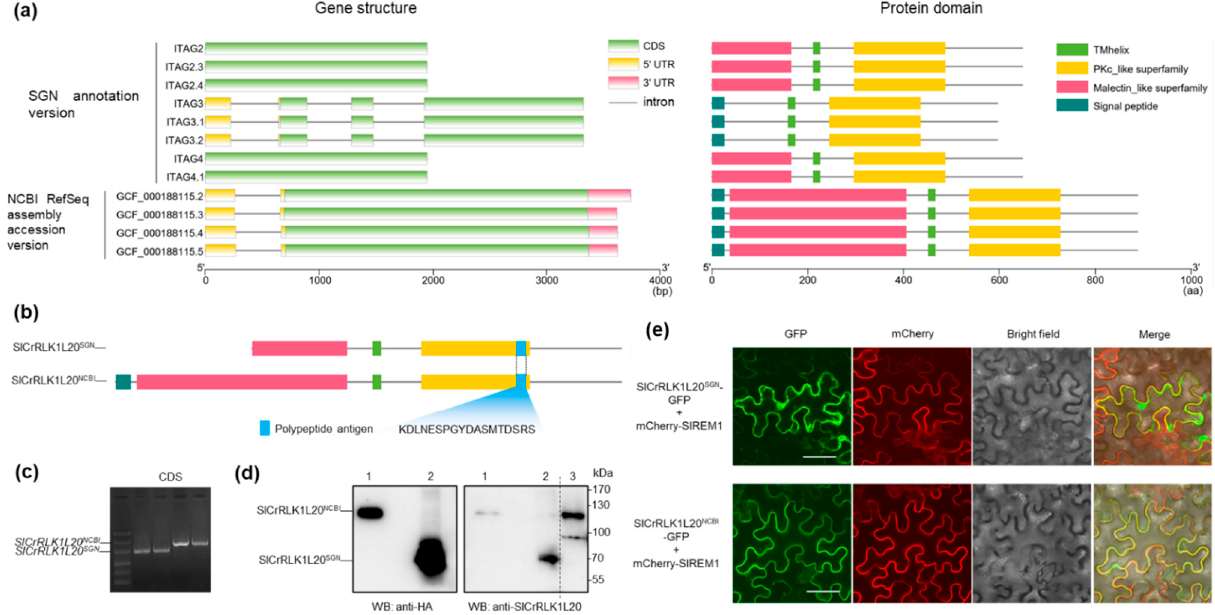
Figure 2. The accuracy of the tomato CrRLK1L annotations in NCBI was higher than that in SGN. ( a ) The different versions of the gene structure and protein domain of SlCrRLK1L20 in the NCBI and SGN databases. The data were extracted from NCBI and SGN and then analyzed for visualization; detailed information can be found in Table S2. ( b ) Polypeptide antigen location in SlCrRLK1L20 NCBI and SlCrRLK1L20 SGN . ( c ) Amplification of the SlCrRLK1L20 NCBI and SlCrRLK1L20 SGN CDSs. ( d ) Western blot analysis of SlCrRLK1L20 NCBI and SlCrRLK1L20 SGN . 1: N. benthamiana leaves transiently expressing CaMV35S::SlCrRLK1L20 NCBI -HA; 2: N. benthamiana leaves transiently expressing CaMV35S::SlCrRLK1L20 SGN -HA; 3: S. lycopersicum fruit. The uncropped Western blot gel image can be found in Figure S2. ( e ) Confocal analysis of SlCrRLK1L20 NCBI and SlCrRLK1L20 SGN subcellular localization. Bars = 50 μ m.